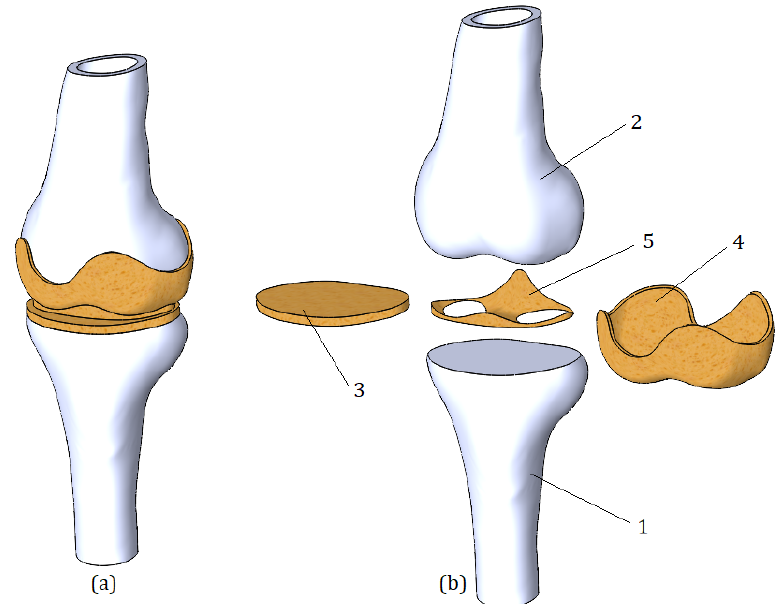
Figure 2. ( a ) Numerical knee joint model; ( b ) Model components: 1—tibia, 2—femur, 3—tibia cartilage, 4—femur cartilage, 5—meniscus.